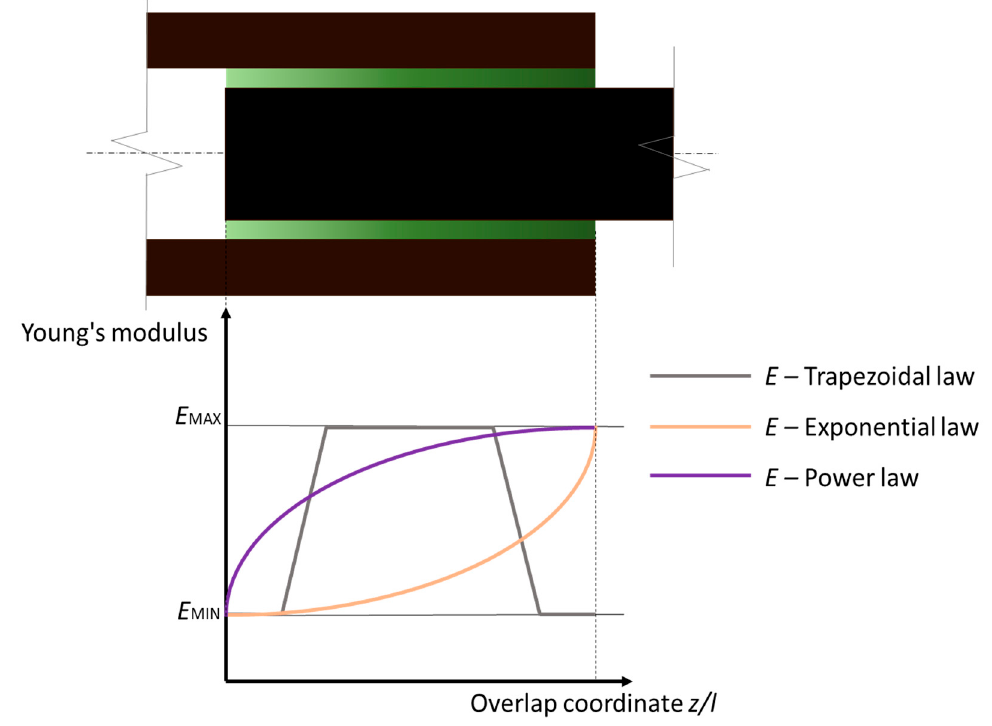
Figure 4. Seamless bond line modulus tailoring using DMs for tube-shaft joint [25,26].